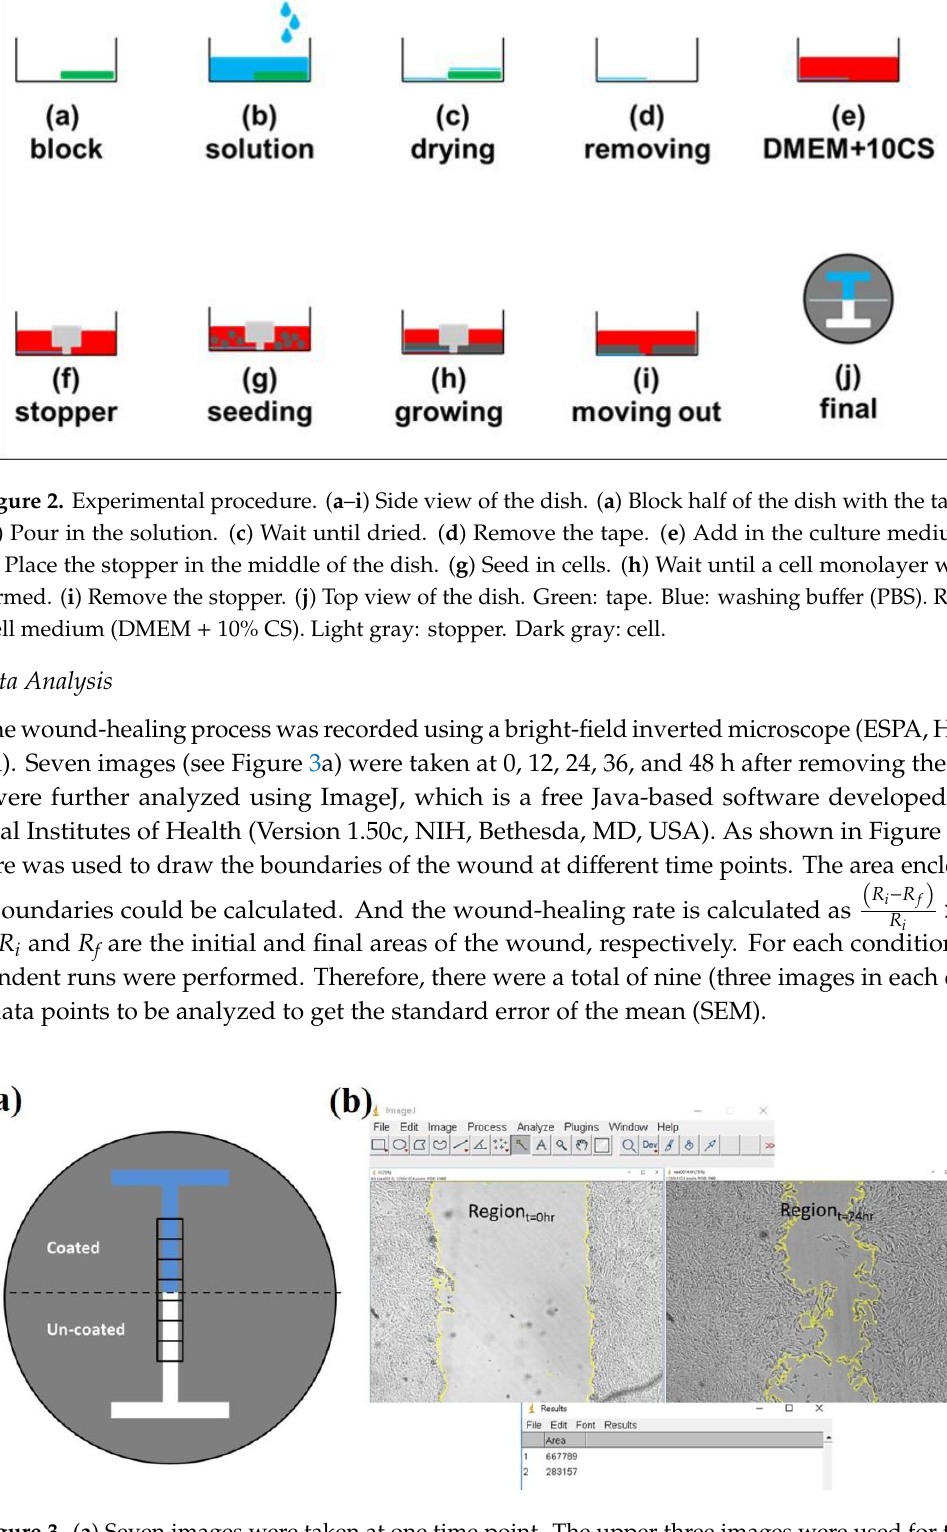
Figure 3. ( a ) Seven images were taken at one time point. The upper three images were used for the coated substrate. The lower three images were used for the uncoated substrate. ( b ) ImageJ was used to draw the boundaries and calculate the area of the wound.